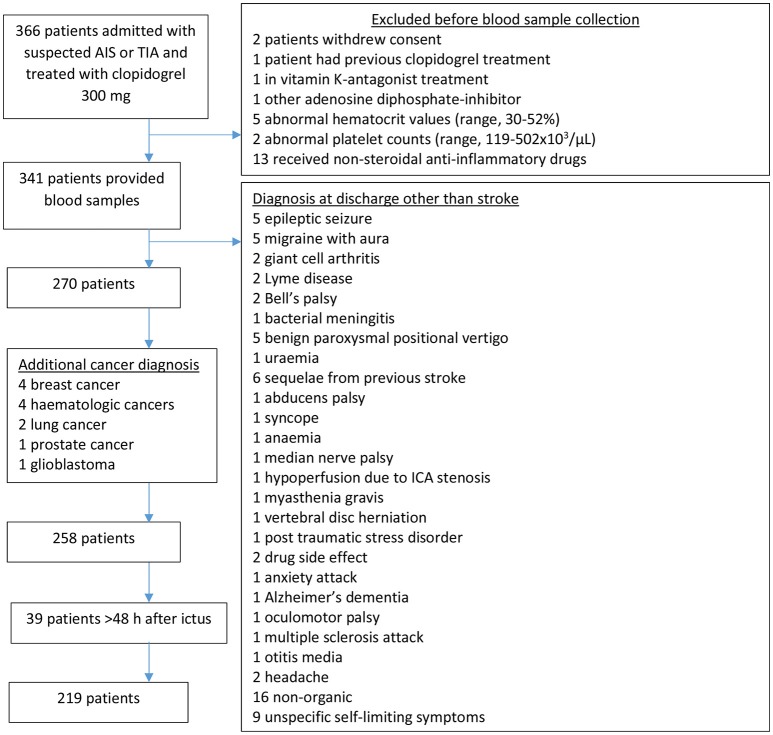
Study flow chart. The stroke unit is a primary treatment center receiving patients not previous seen by a physician. AIS, acute ischaemic stroke; TIA, transient ischaemic attack; ICA, internal carotid artery.